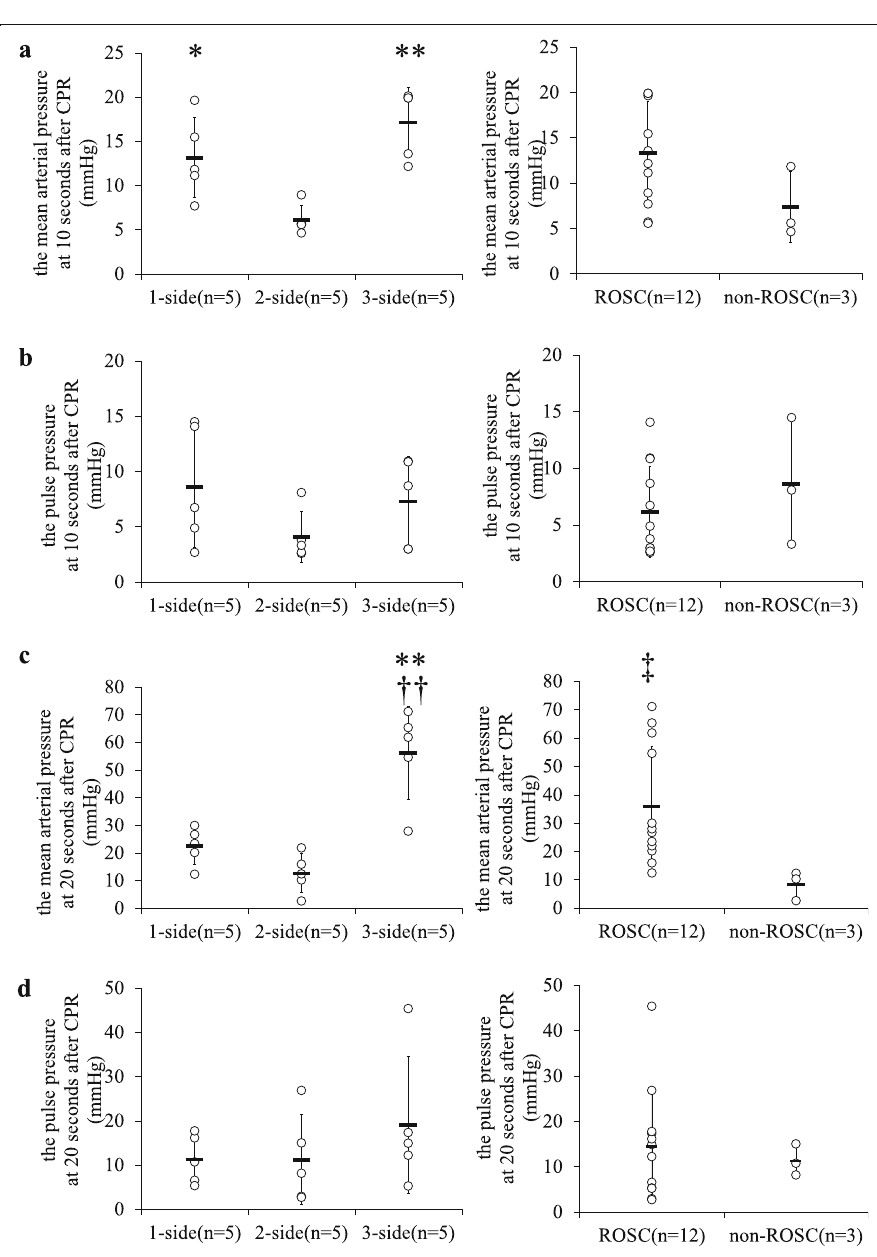
the difference between CCA and FA pressures, the left ventricle pressure, and the car- diac output. These findings may increase the brain oxygenation and EtCO important indicators of the quality of CPR [2].